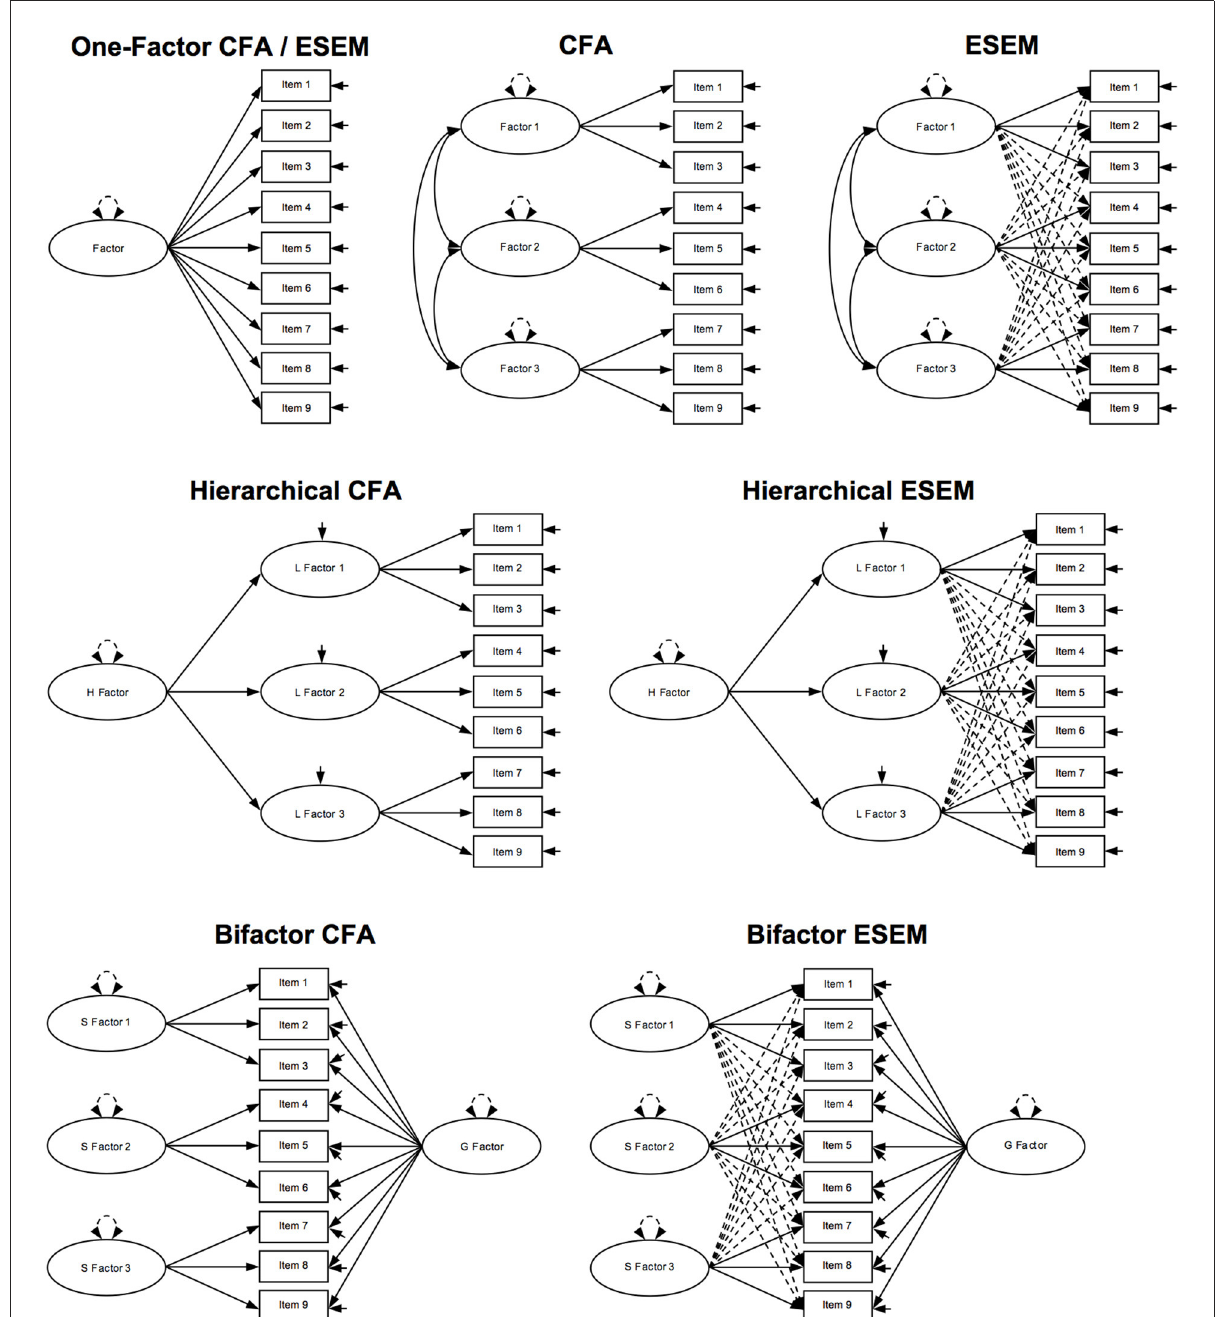
FIGURE1 Schematic model representations. Ovals represent latent factors; squares represent observed variables; full unidirectional arrows between ovals and squares represent factor loadings; dotted unidirectional arrows between ovals and squares represent cross-loadings; full unidirectional arrows linked to a single oval represent factor disturbance; full unidirectional arrows linked to a single square represent item uniqueness; bidirectional full arrows between ovals represent factor covariances/correlations; bidirectional dashed arrows linked to a single oval represent factor variance; CFA, confirmatory factor analysis; ESEM, exploratory structural equation modeling; H Factor, higher-order factor in a hierarchical model; L Factor 1–3, lower-order factors in a hierarchical model; S Factor 1–3, specific factors in a bifactor model; G Factor, general factor in a bifactor